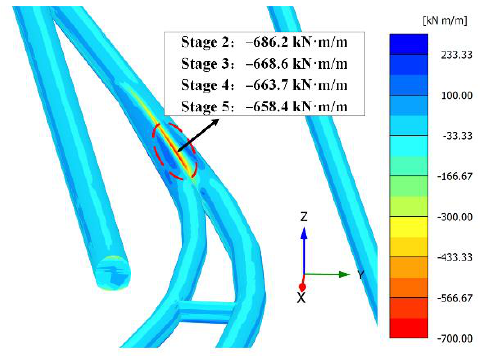
Figure 13. Nephogram of tunnel lining moment.